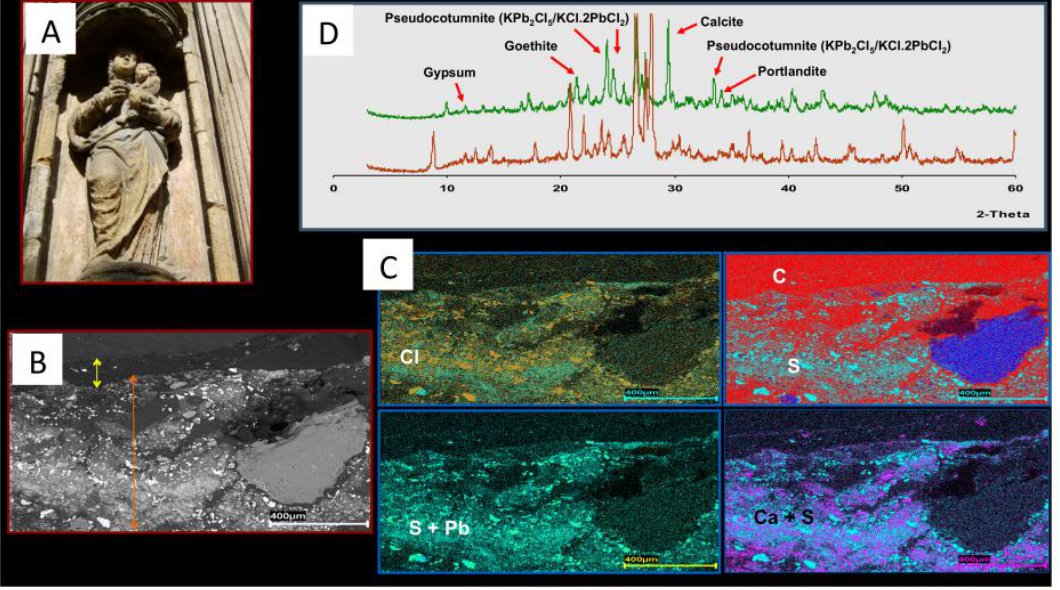
Figure 3. Covering layer on the façade of Fonseca Palace (Santiago de Compostela). ( A ) Full view of the sculpture where the covering layer was taken, ( B ) SEM picture of a cross-section of the covering layer, ( C ) EDS from di ff erent zones of the inner layer surface, and ( D ) XRD spectra of the covering layer (green line) and of the granite underneath the covering layer (brown